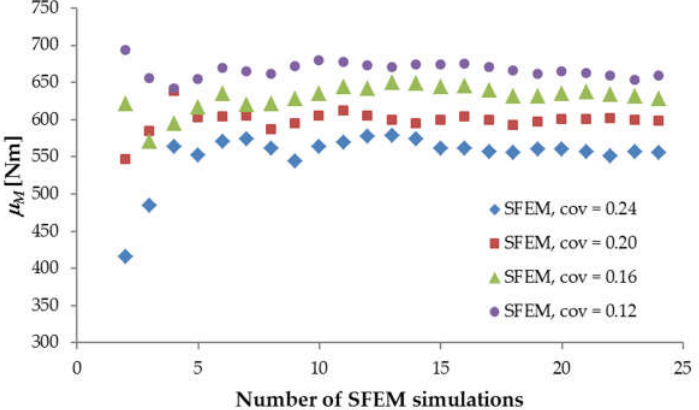
Figure 5. The calculated mean ultimate bending moment μ M against the number of SFEM simulations for beam LM200.